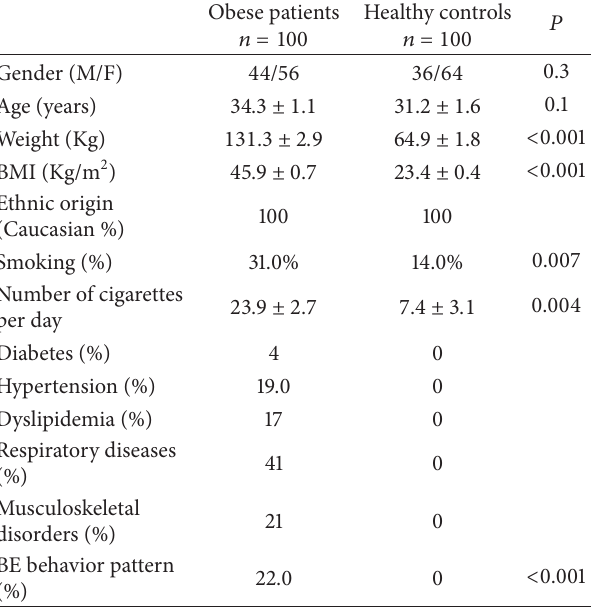
Table 1: Demographic characteristics, anthropometric data, and prevalence of comorbidities and of BE behavior pattern in the Italian obese patients and healthy controls. Data are expressed as percentage (%) or as mean ± SE.